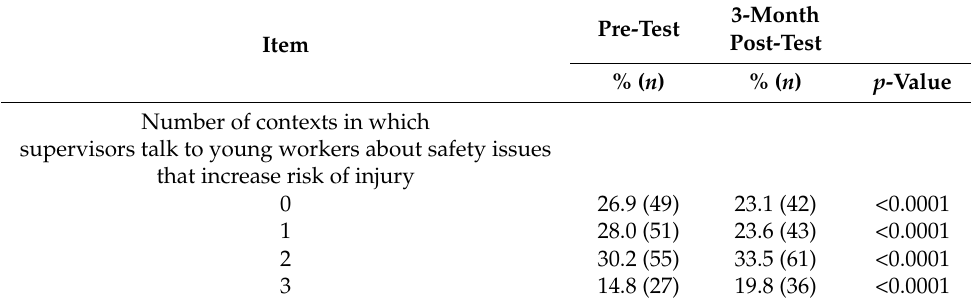
Table 8. Changes in the number of contexts that supervisors talk about safety and health (i.e., at hire, when assigning tasks, and/or following a near miss/injury) before and after completing the training ( n = 182)